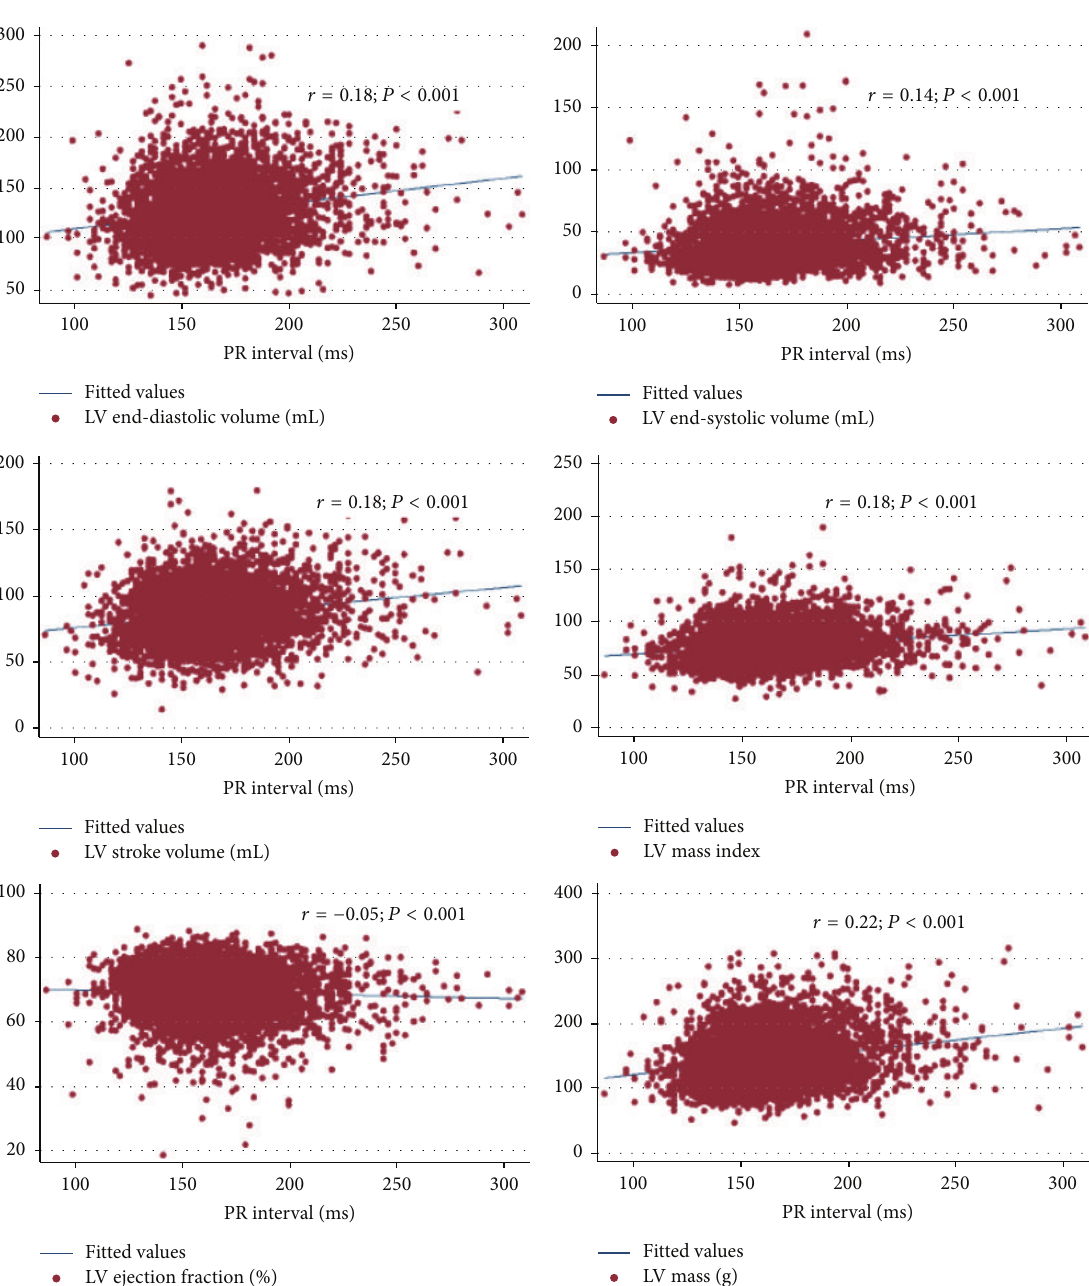
− 9.17, − 0.39) compared to a PRi 120–200 ms after adjust- ment for all covariates. However, compared to a PRi 120– 200 ms, no significant association was noted between a PRi < 120 ms and LV mass, LV mass index, LV end-systolic or end- diastolic volume, or ejection fraction in any of the models (data not